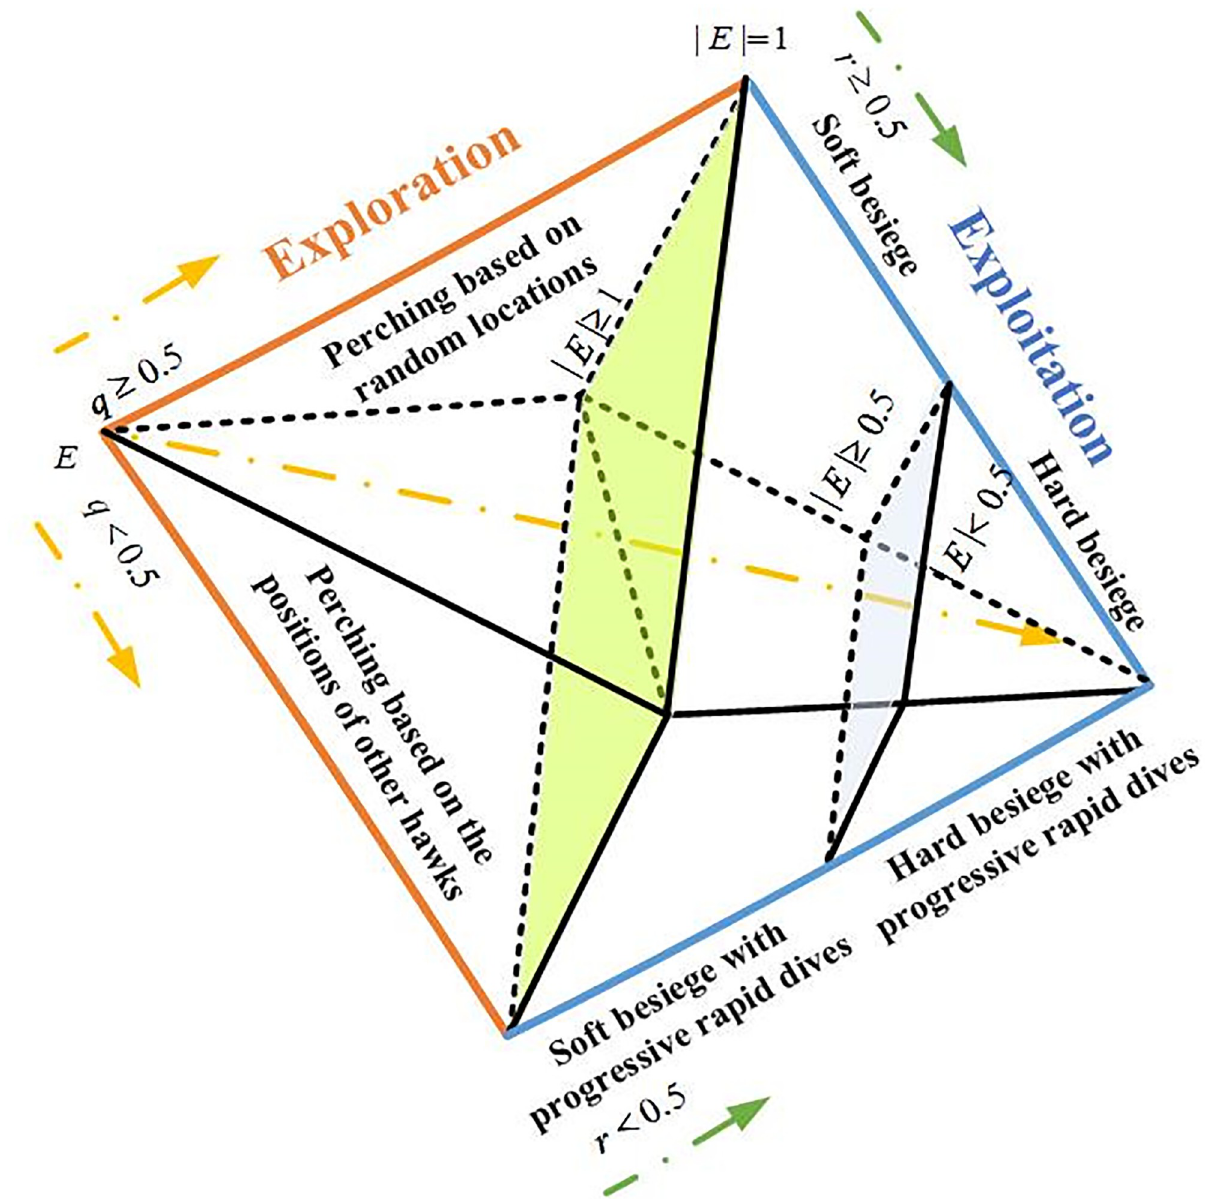
Fig 1. Different phases of HHO (Heidari et